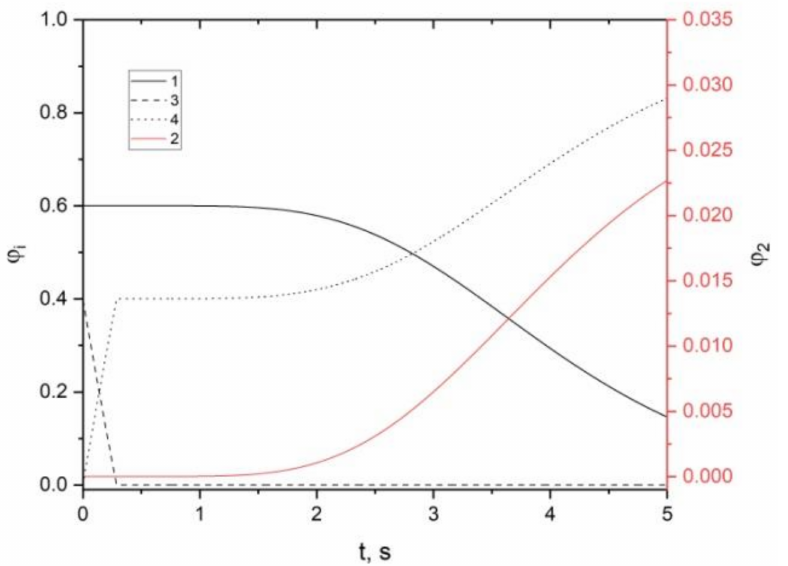
Figure 8. Distribution of volume fractions of phases under the influence of a low-intensity surface forest fire depending on time (summer, July, +20 ◦ C, ϕ 30 = 0.4, α s = 0.05): 1—dry organic matter, 2—soot particles, 3—moisture,